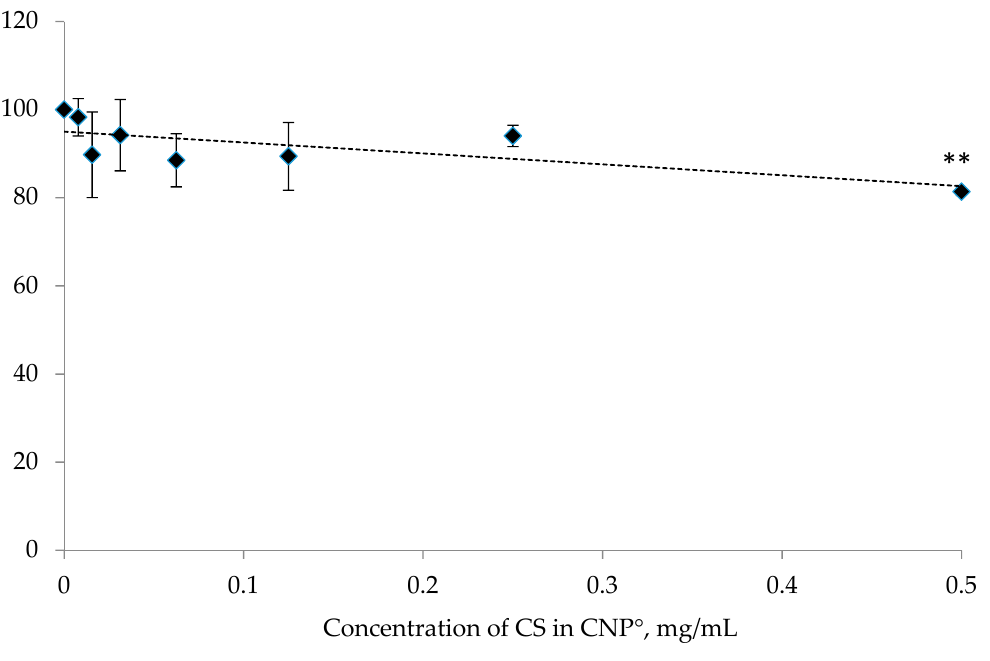
Figure 12. In vitro cytotoxicity test of CNP° at different concentrations. Error bars represent the SD of three independent replicates of the experiment. At the highest dosage, CNP° appeared to be non-toxic to 786-O cells upon 24 h post-treatment. * shows degree of significant difference, P < 0.0305 compared to control.